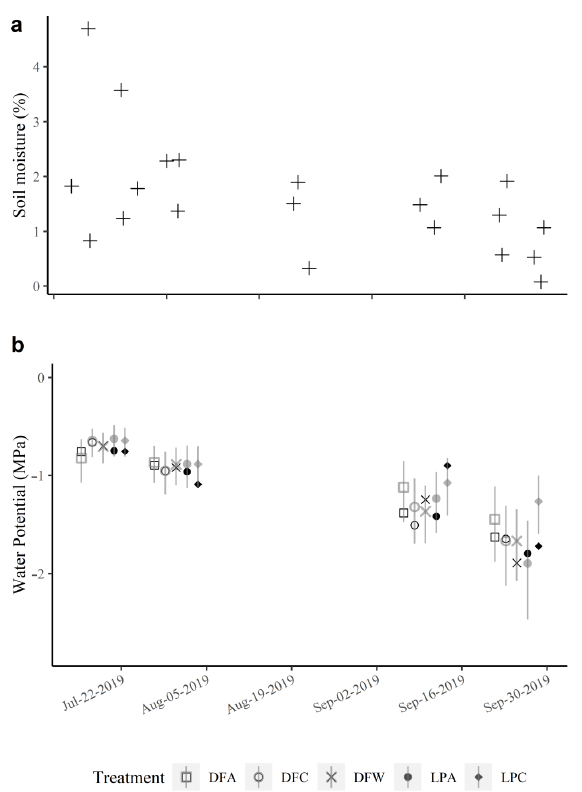
Figure 1. Soil moisture ( a ) and its direct relationship with leaf water potential ( b ) to treatments dur- ing the first three months post-treatment in 2019 near Red Feather Lakes, CO, USA. DF = Douglas- fir, LP = lodgepole pine, A = Aggressive, C = Control, and W =